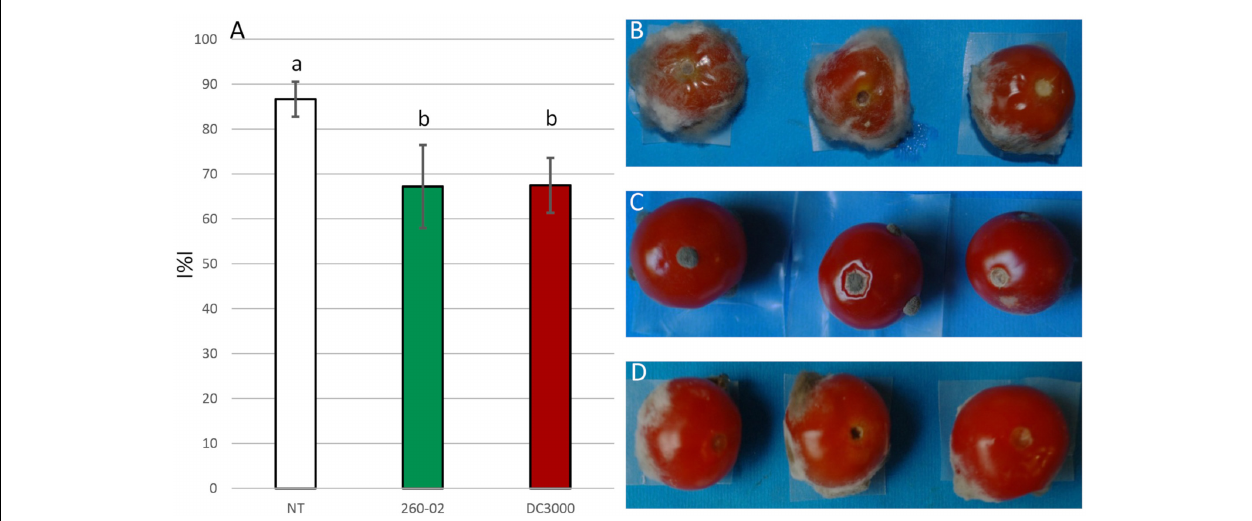
FIGURE 3 | Results of the in vivo assays. (A) Graph reporting the percentage infection index (I%I) observed on tomatoes inoculated with BC alone (NT), or previously treated with either strain 260-02 or strain DC3000. The bars indicate the mean I%I value observed on three replicates of the experiment, each carried out on 10 fruits. Different letters (a,b) indicate significantly different results according to One-Way ANOVA test, followed by Tukey’s Exact post hoc ( p < 0.05). On the right side, pictures of three representative tomatoes that were (B) non-treated, (C) treated with strain 260-02, and (D) treated with strain